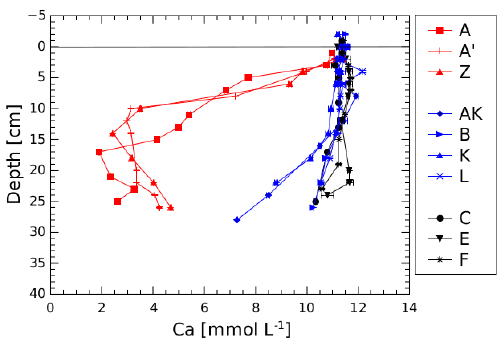
Figure 7. Porewater concentrations of Ca 2 + (mmolL − 1 ) ; proximal domain in red, prodelta domain in blue and distal domain in black. The error bars represent the uncertainties of the ICP-AES measure-